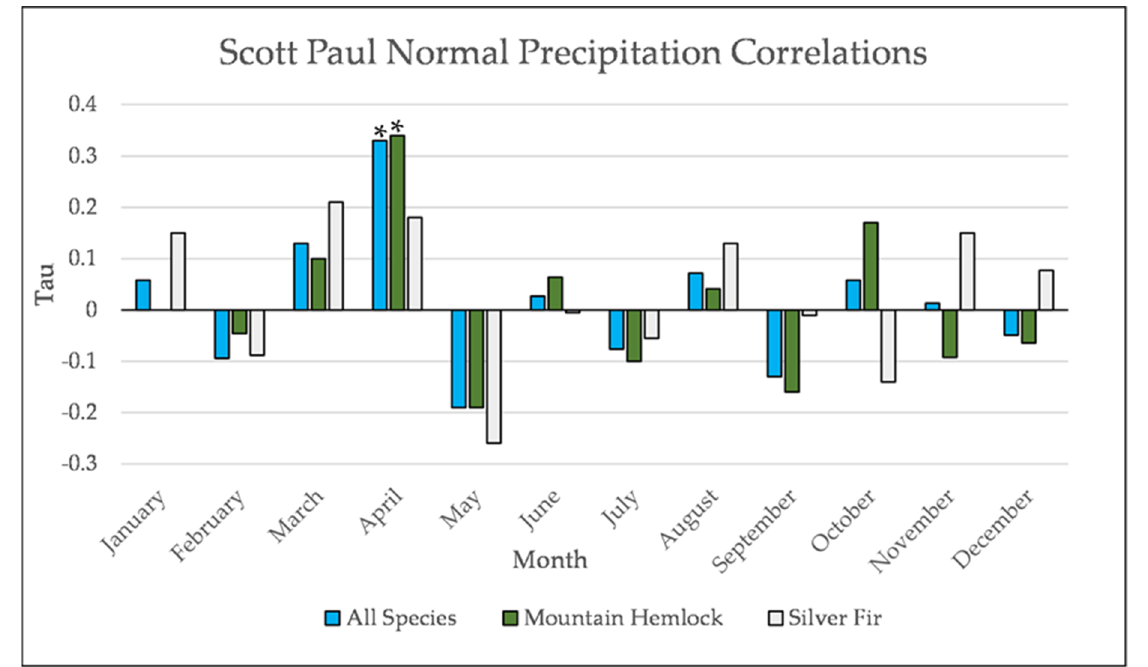
Figure A22. Normal Kendall’s correlation between mean monthly precipitation and establishment at the Scott Paul site. * = p -value < 0.05.